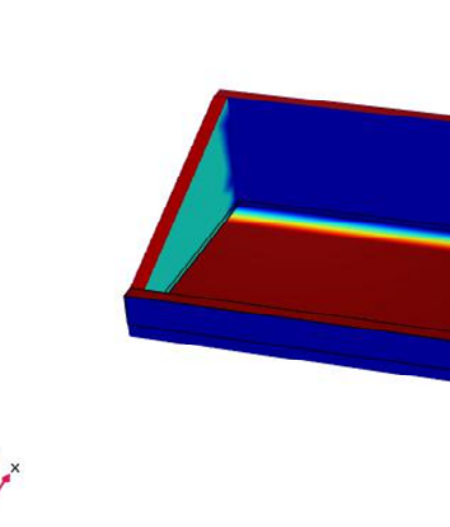
Figure 4. Solar irradiation (in W/m2) on the solar still (simulation time = 10 am).